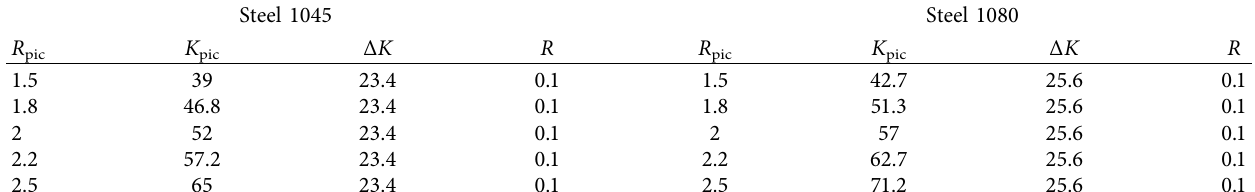
Figure 5: Schematic illustration of applied loading. Table 2: Loading parameters.